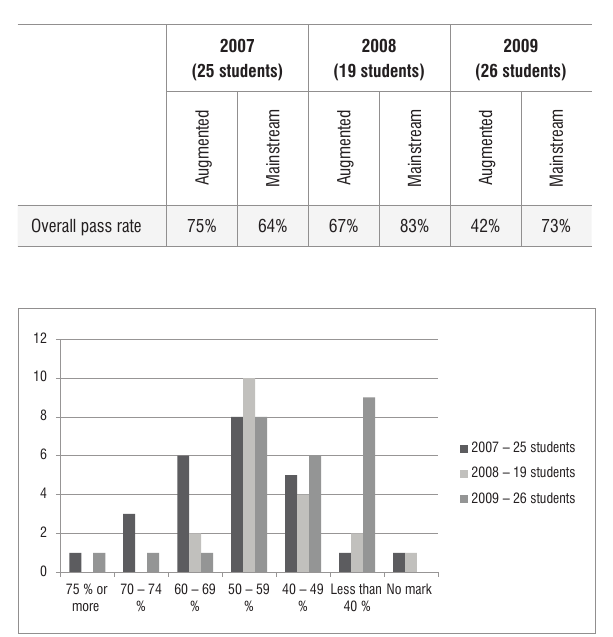
Pass rates for the final exam for each cohort